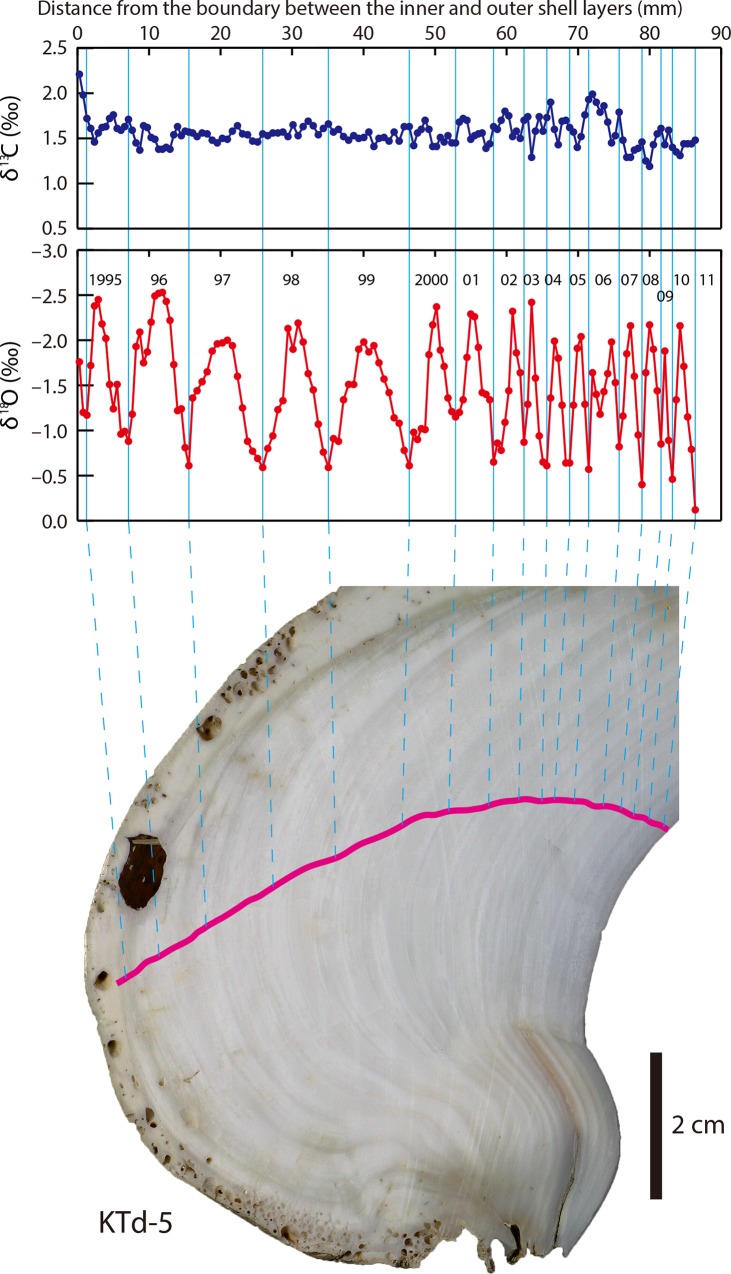
δ13Cshell and δ18Oshell profiles of a Tridacna derasa shell (KTd-5).Pink line indicates the sampling transect.